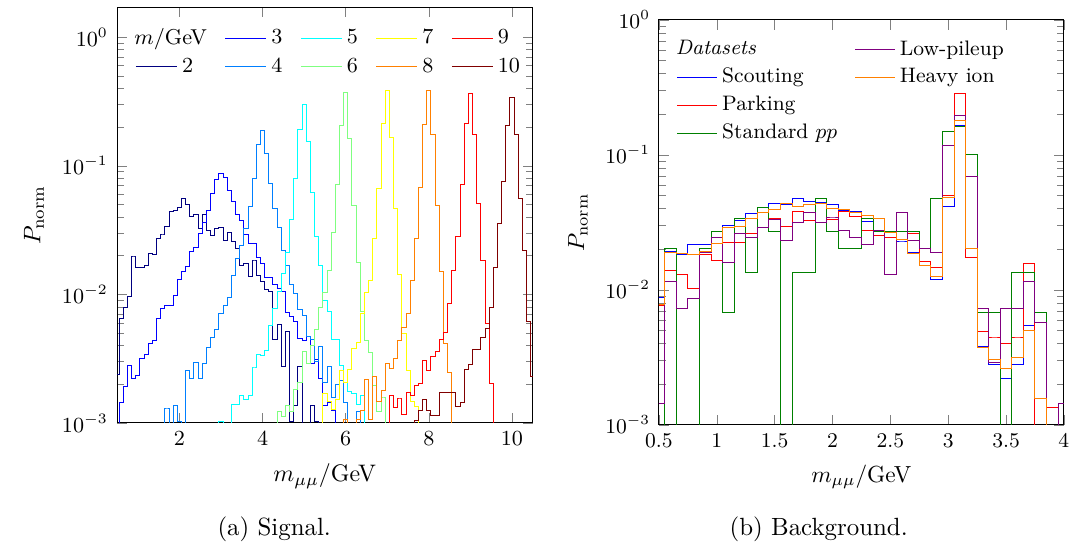
Figure 2 : Probability distribution function P norm as function of the dimuon invariant mass for the signal events with nine different masses in panel (a) and the background events for the five different datasets in panel (b). The signal distributions are shown for the scouting dataset. The hybrid trigger thresholds are used for both the signal and background